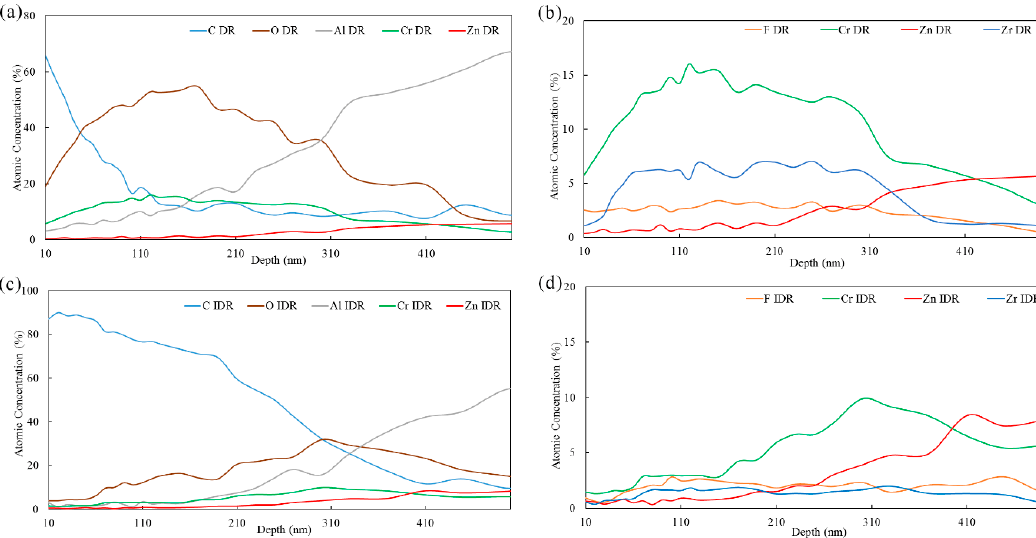
Figure 11. AES elemental atomic in-depth distribution of selected points on TCC formed by 180 s at 40 ° C in the TCP bath: ( a , b ) dendritic region and ( c , d ) inter-dendritic region.